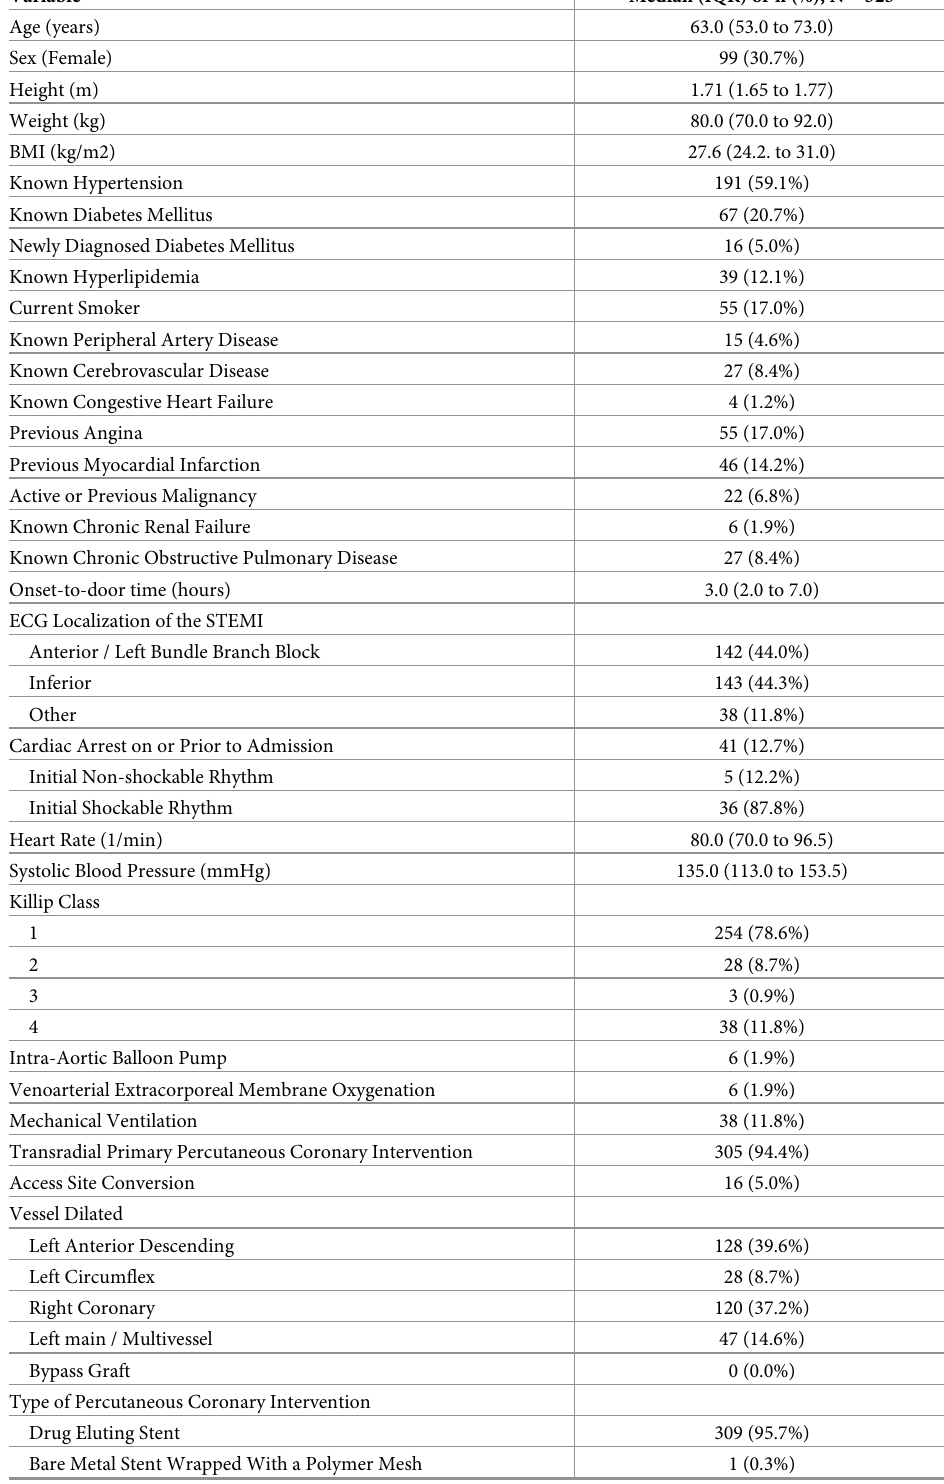
Table 1. Demographic, clinical, procedural characteristics and baseline laboratory